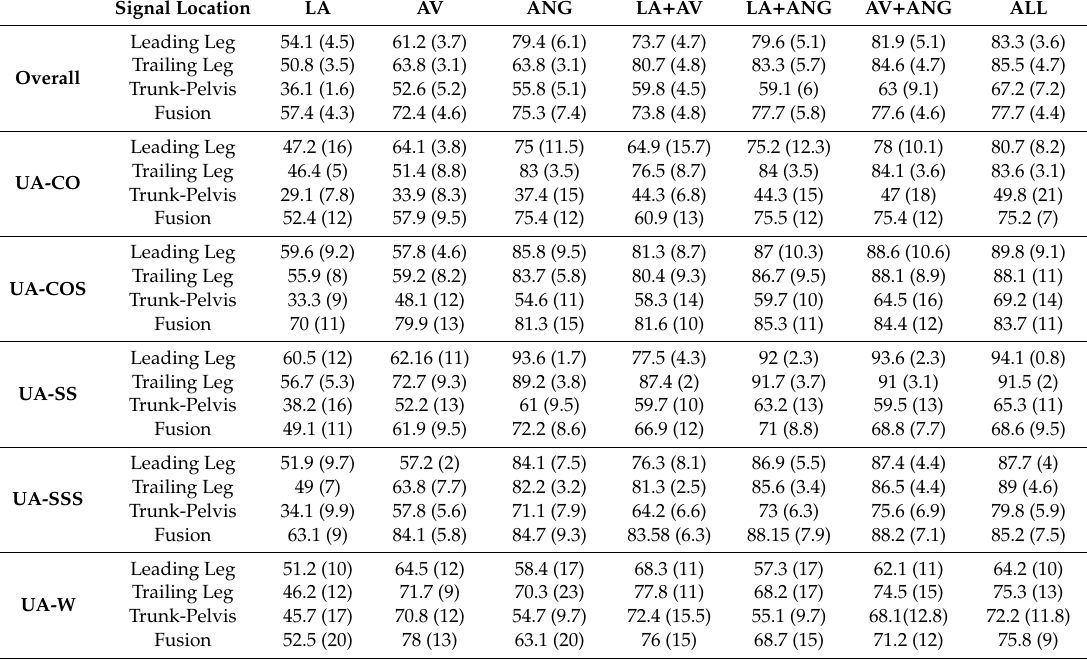
Figure 4. Classification accuracy of unanticipated straight walking (UA-W), crossover and sidestep cuts (UA-CO, UA-SS), cuts to stair ascent (UA-COS, UA-SSS), as well as overall accuracy across transitions using signals of varying modalities (LA, AV, ANG, LA + AV, LA + ANG, AV + ANG, ALL) and locations (the leading leg, trailing leg, trunk–pelvis, and fusion across locations). Asterisks denote modalities that were statistically different from signal combinations (alpha = 0.05). Table 2. Classification accuracy of unanticipated locomotion modes (UA-CO, UA-COS, UA-SS, UA-SSS, UA-W), as well as overall accuracy across transitions using signals of varying modalities and locations. Values represent the mean (standard deviation).